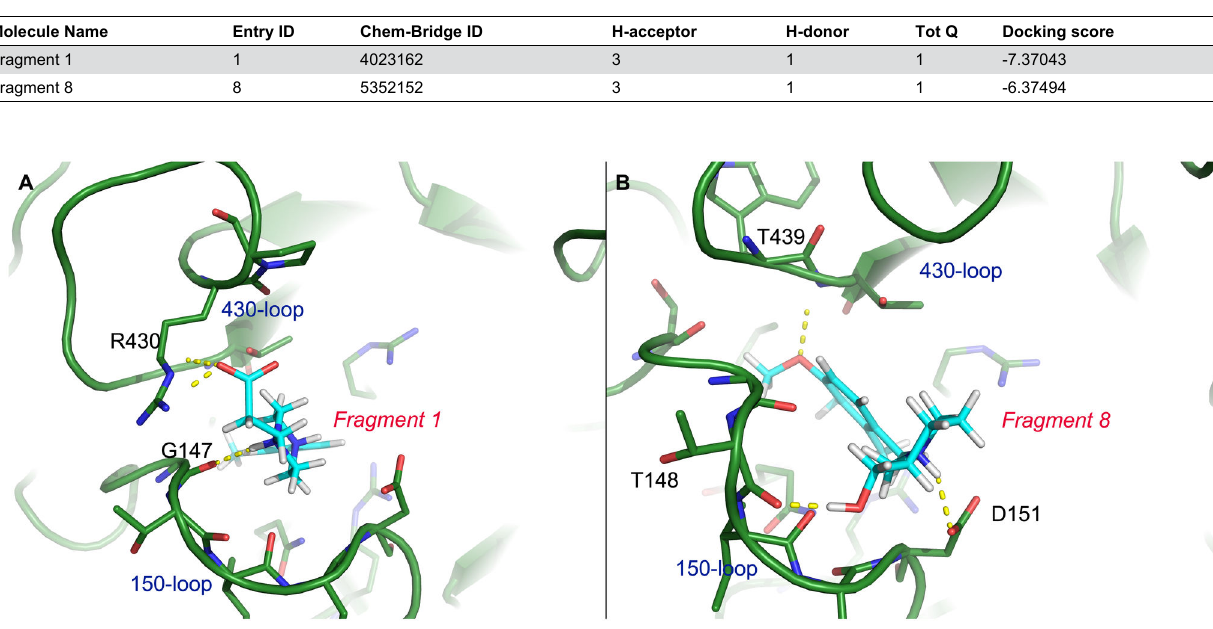
Figure 4. Illustration of virtual screening results of the successfully linked fragments. Panels A and B show the proposed interaction patterns of Fragment 1 and Fragment 8 with 09N1 by virtual screening of a fragment library against the 150-cavity of 09N1. Polar contacts are shown as yellow dashed